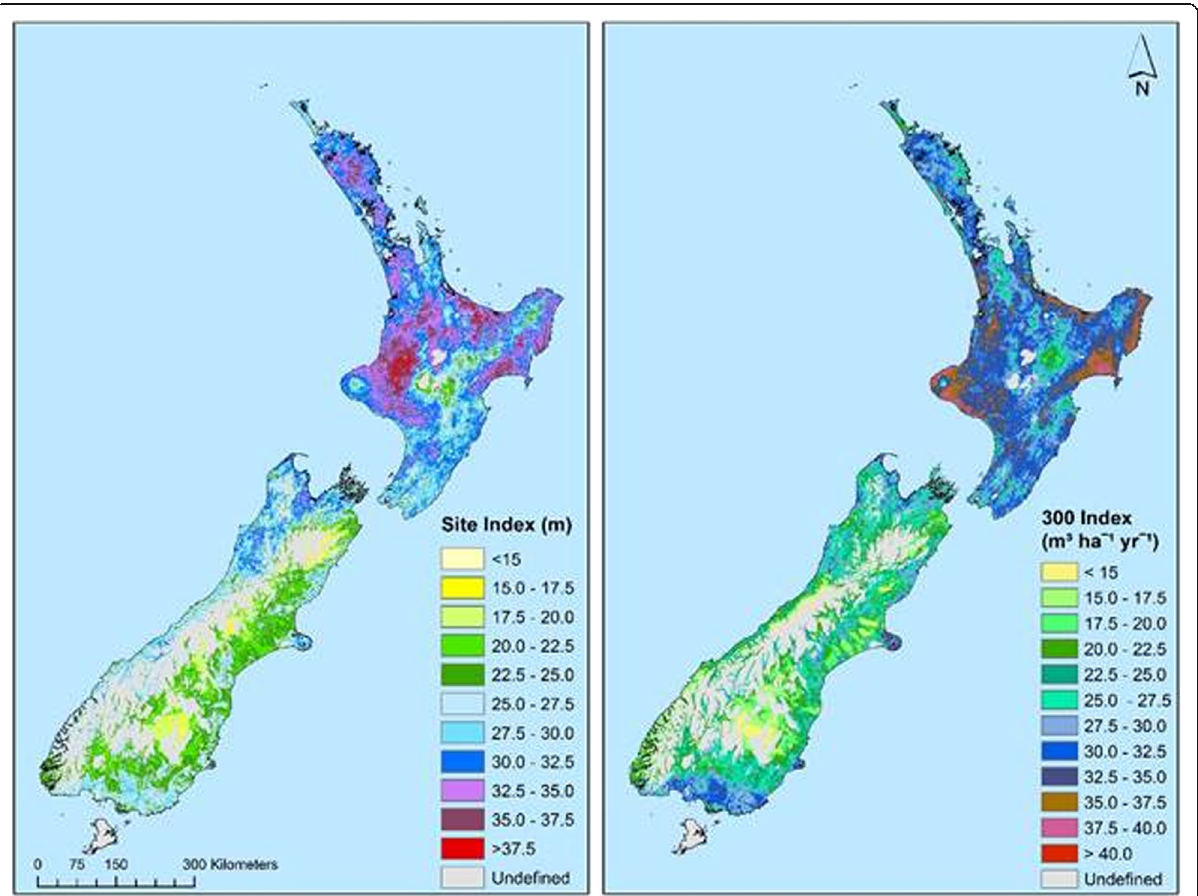
Fig. 2 Title: Spatial variation across New Zealand in Site Index and 300 Index. Spatial variation across New Zealand in (left) Site Index and (right) 300 Index. Predictions were constrained to the potential range of P. radiata by excluding areas with mean annual temperature < 7.9 °C